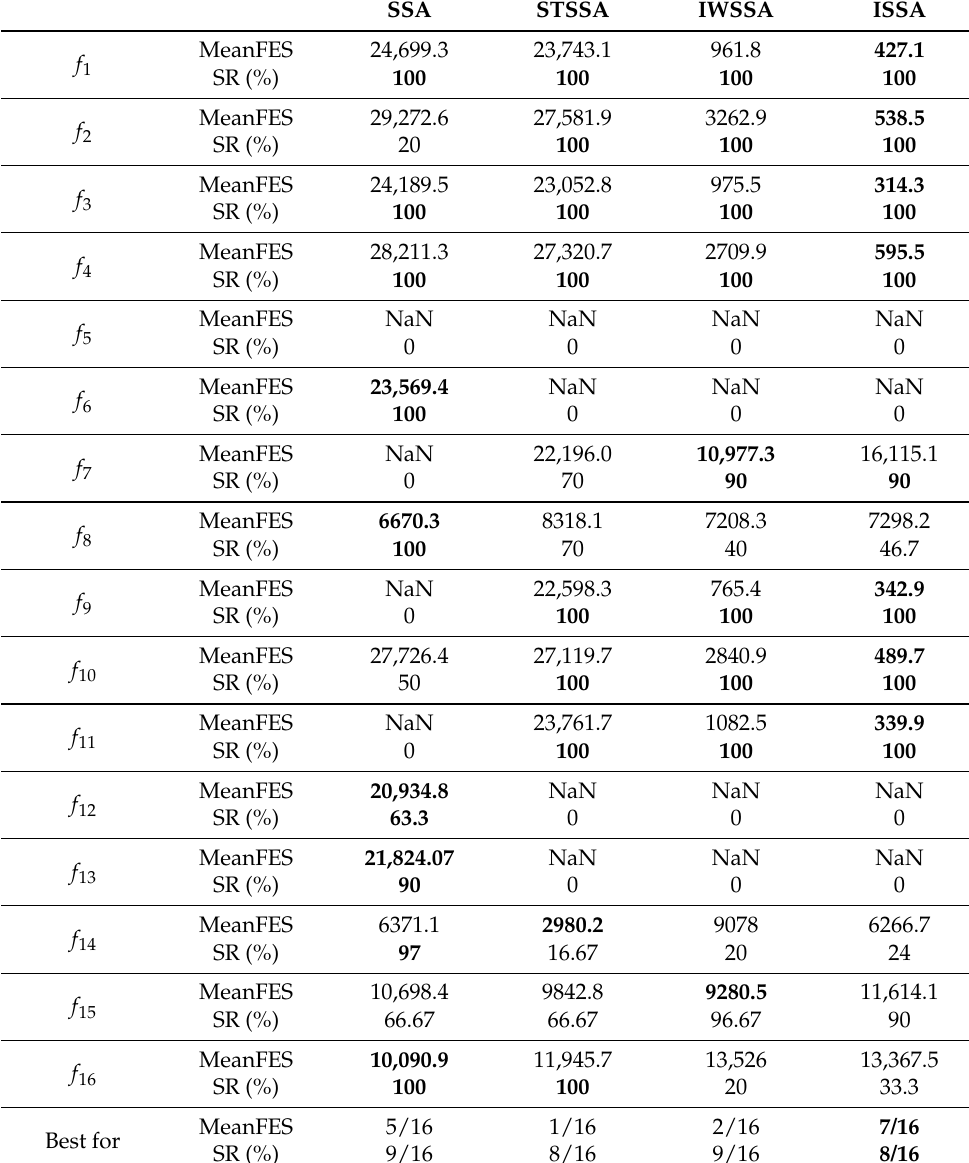
Table 2. MeanFES and SR by comparative algorithms for the functions f 1 − f 16